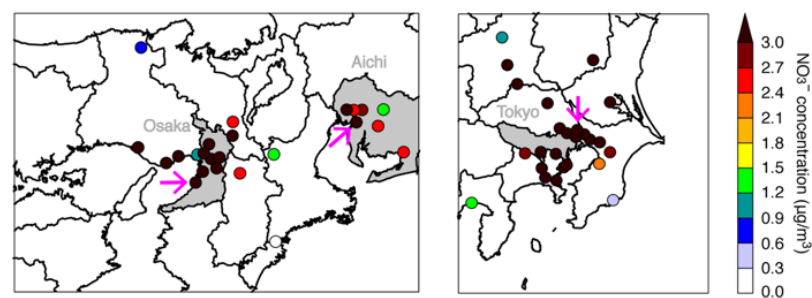
Figure 2. Spatial distribution of the observed NO 3 − concentration at APMSs averaged during winter over (left) domain 3 and (right) domain 4. The area colored in grey indicates (left) Osaka and Aichi prefectures and (right) Tokyo metropolis. Three specific sites indicated by pink arrows in Osaka, Nagoya, and Tokyo were used for further analysis.